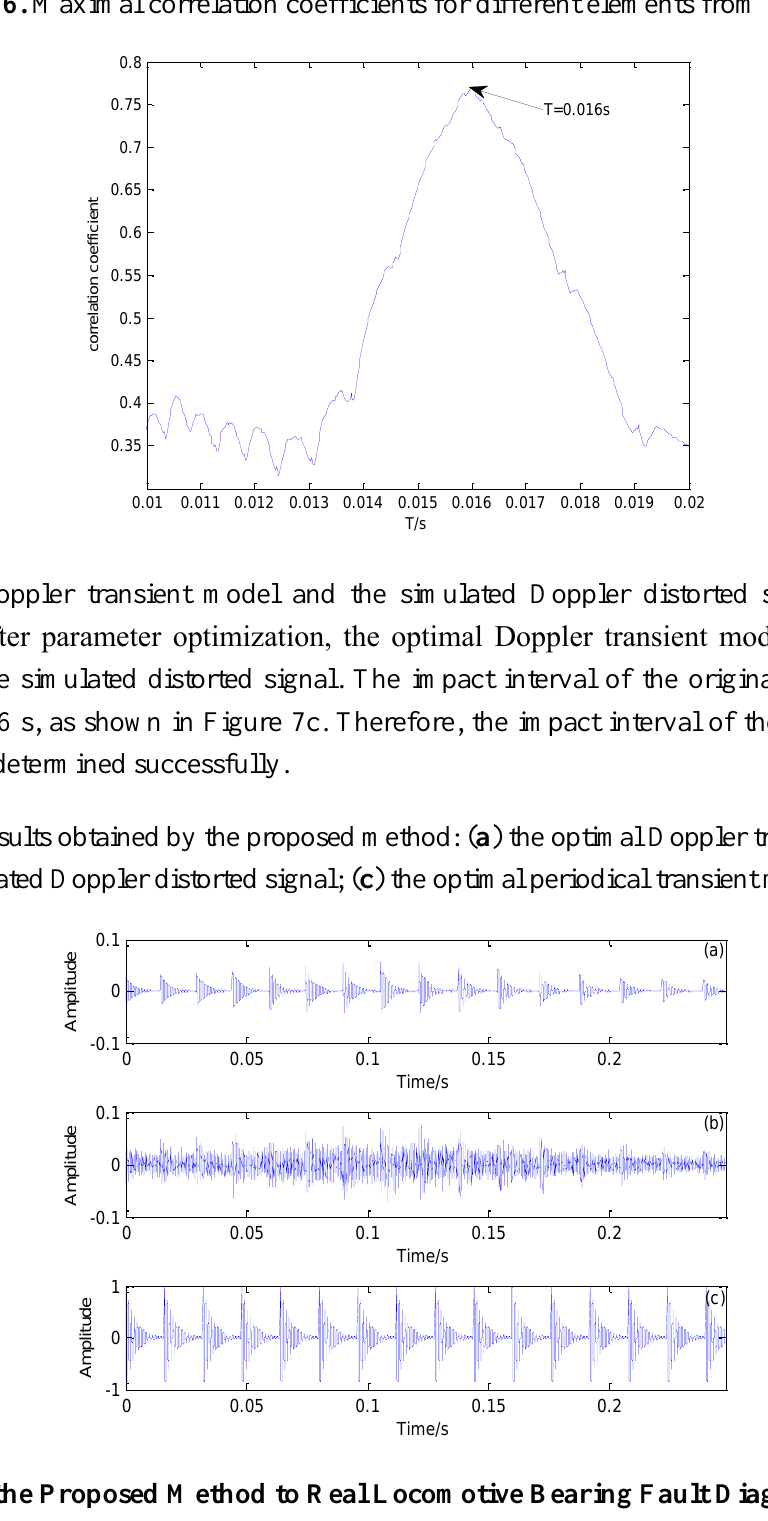
Figure 6. Maximal correlation coefficients for different elements from the set T .